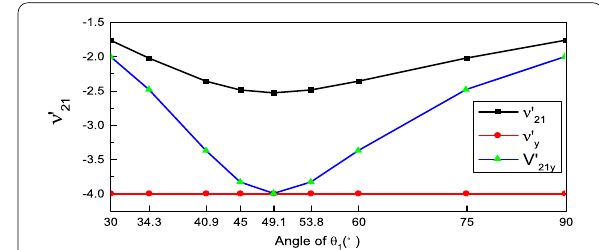
Figure 15 Elastic modulus E ′ 2 with varying θ 1 angle in the σ 2 direction